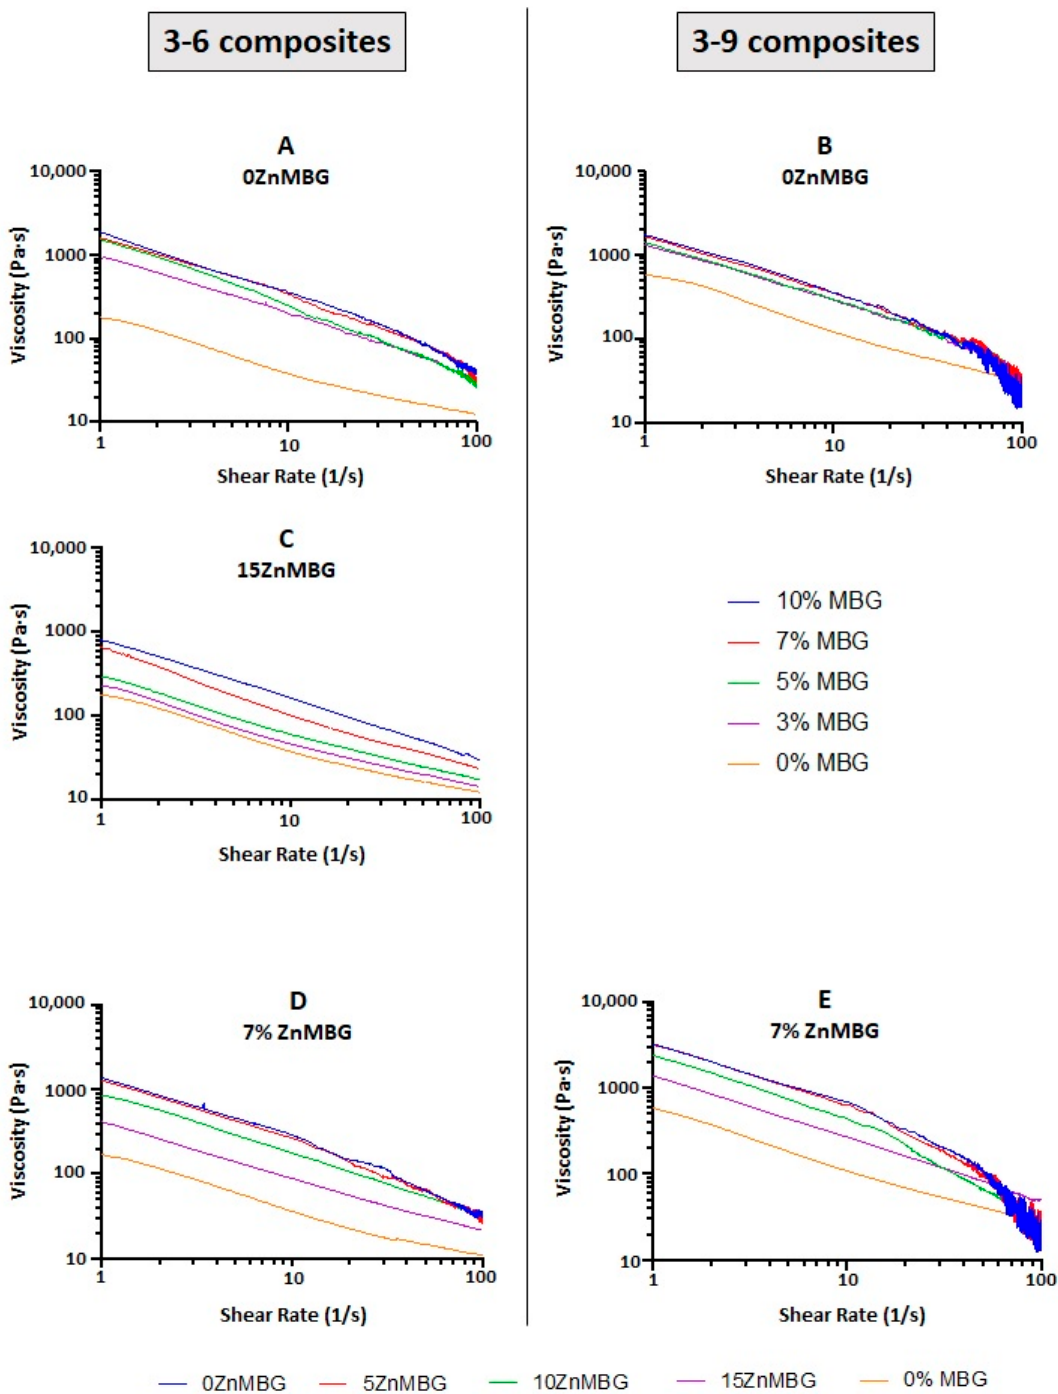
Figure 2. Rheological analysis of composite inks. Representative curves out of 3 measurements for each composition: ( A ) 3–6 algMC blend and ( B ) 3–9 algMC blend with different amounts of basic MBG containing 15% Ca and no Zn (0ZnMBG), ( C ) 3–6 algMC blend with different amounts of MBG containing 15% Zn and no Ca (15ZnMBG), ( D ) 3–6 algMC blend and ( E ) 3–9 algMC blend with 7% of MBG containing different amounts of Zn (0, 5, 10 and 15%) and Ca (15, 10, 5, 0%).